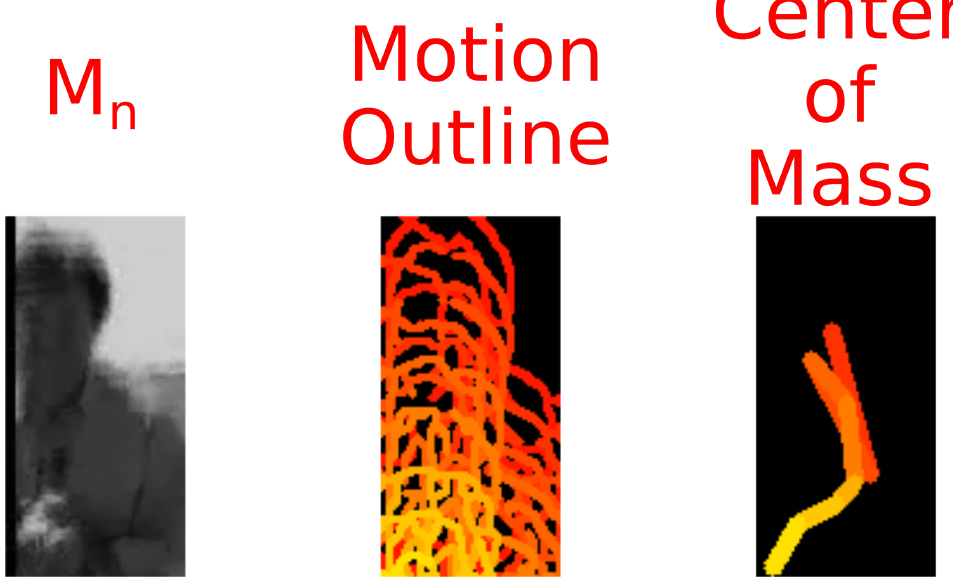
Figure 9. By focusing on regions of interest in the video of the Spitfire flyby, we can track the actions of individual components. Here, most of the frame has been cropped, leaving only the scared reporter flinching as the plane flies above. As mentioned in Figure 8, the UnCanny filter determines the motion as outlines of the actor. By calculating the center of mass of these outlines, we can determine the movement vector. In the rightmost image, the centroids from the center image are shown as connected lines, demonstrating this movement vector